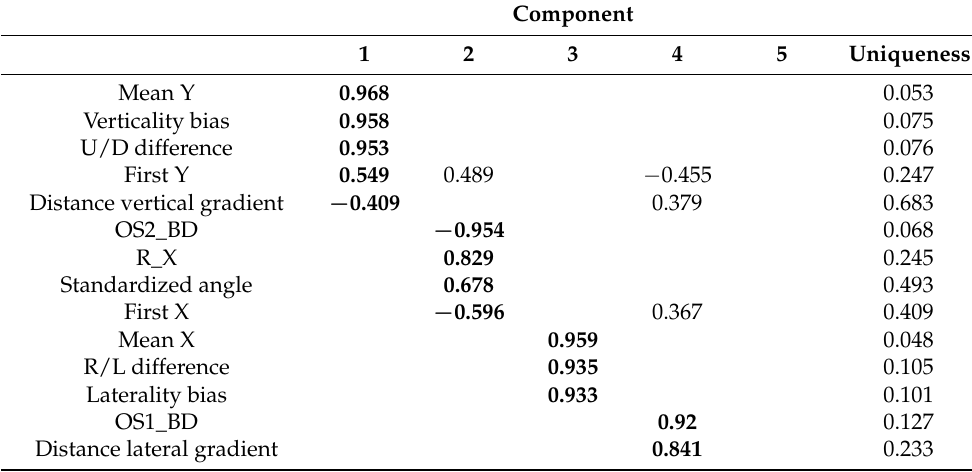
Table 4. Summary of the principal component analysis for the indexes ( n = 122). Eigenvalues and Figure 2); OS2_BD = optima sequence number 2_between distance (vertical, see Figure